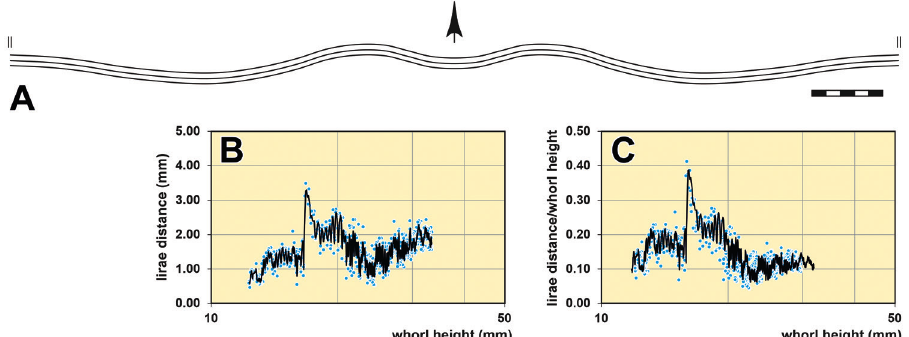
Fig. 57. Lituites bottkei sp. nov. A . Lirae of holotype MB.C.29651 (Bottke Coll.) from Gärdslösa (Island of Öland, Sweden), at wh = 32 mm. B–C . Ontogenetic development of lirae distance (in mm) and lirae distance/whorl height of holotype MB.C.29651. Blue dots = individual measurements, black lines = three data point averaged values. Scale bar units = 1